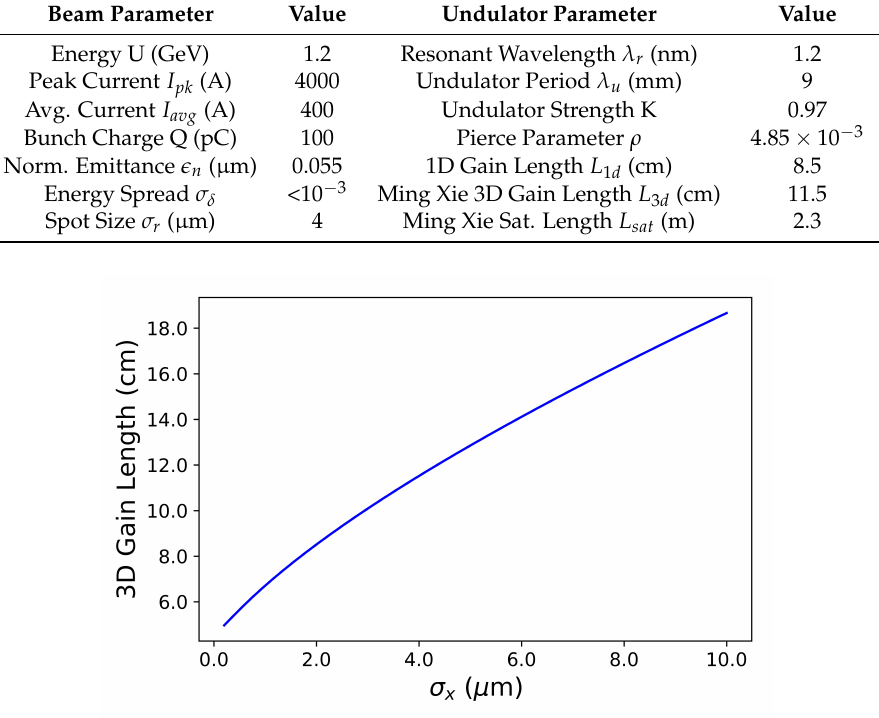
Figure 2. Using the Ming Xie fitting equations modified to include space-charge effects, the 3D gain length as a function of the spot size in the undulator is